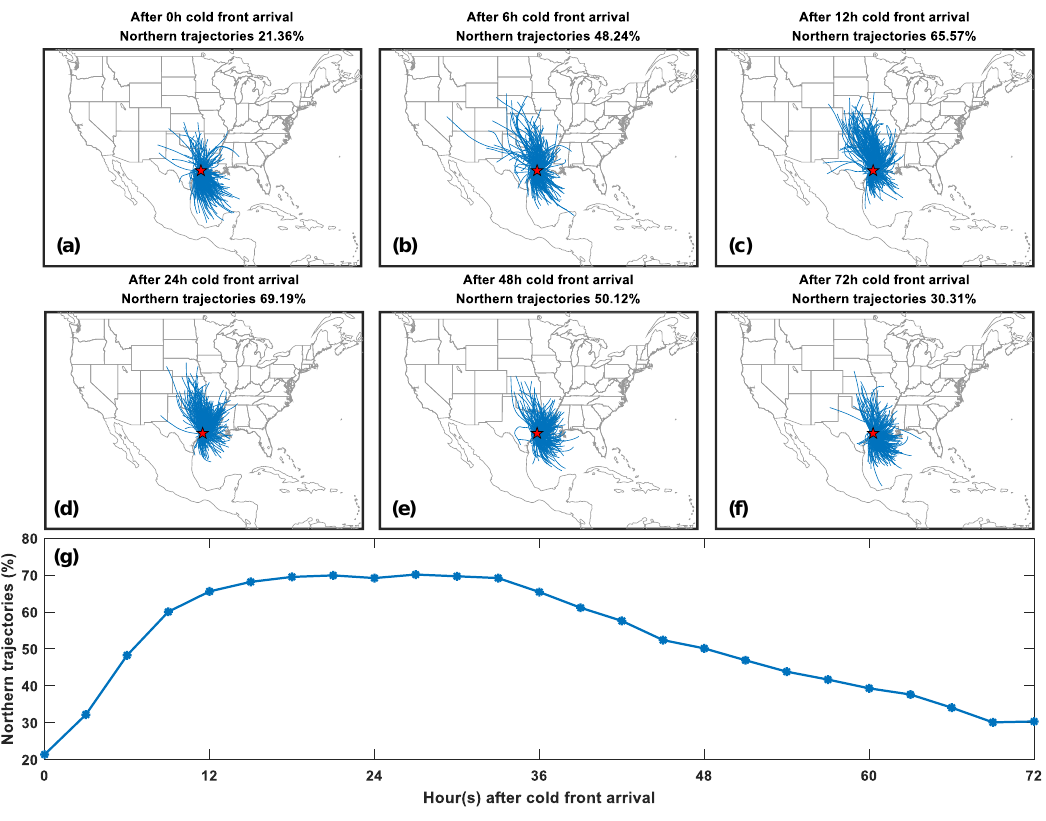
Figure 3. Twenty-four-hour back trajectories start at ( a ) 0; ( b ) 6; ( c ) 12; ( d ) 24; ( e ) 48; and ( f ) 72-h after the cold front line reached the HGB area; ( g ) Time series of northern trajectories percentages every